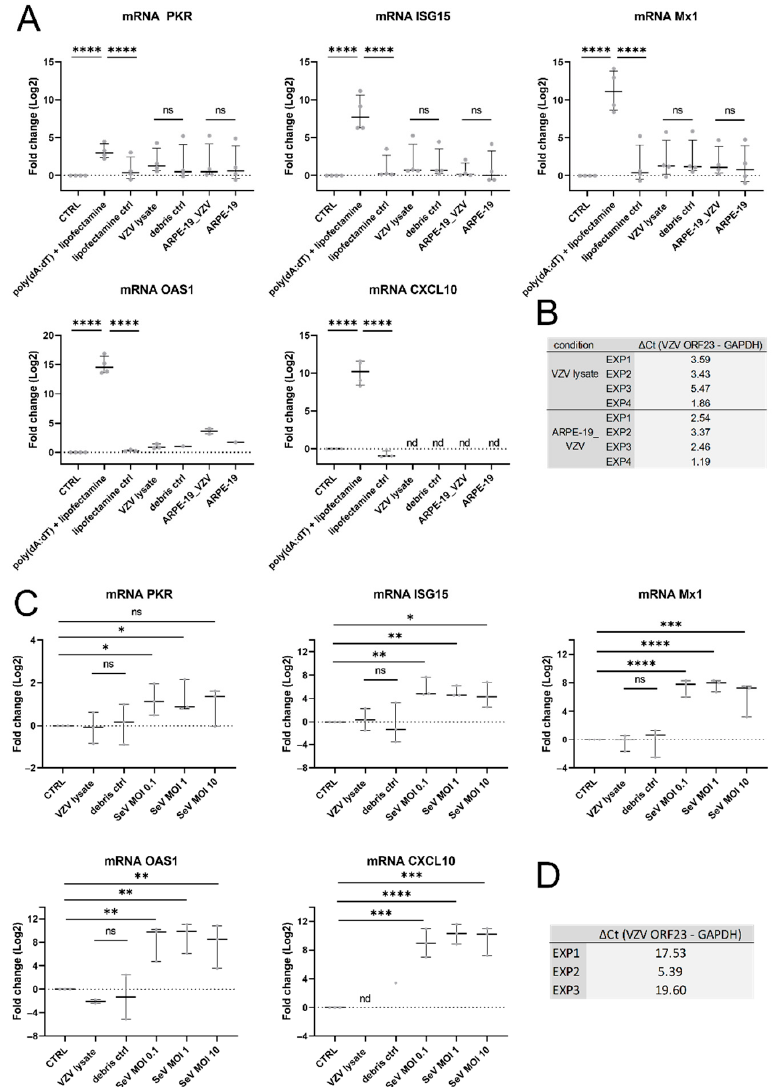
Figure 5. VZV infection does not result in ISG-upregulation in hiPSC neurons. ( A , B ) hiPSC neurons were inoculated with ARPE-19-associated eGFP-ORF23 VZV (ARPE-19_VZV) at a 1:5 ratio or with 1.5 × 10 2 PFU eGFP-ORF23 VZV lysate or their respective control for 72 h. Poly(dA:dT) stimulation for 24 h served as a positive control for the induction of ISGs. Cell lysates were analyzed by RTqPCR. ( A ) Transcript expression (log2) was set out relative to the mean of the untreated non-infected control group (CTRL), i.e., fold change. Each dot represents the log2 fold change of a single culture originating from one of four independent biological repeats. Lines with whiskers indicate the median with interquartile range. The p values reported were obtained from a Linear Mixed Model that was adjusted for multiple testing using Dunnett’s comparisons with control test. ( B ) ∆ Ct values for VZV ORF23 mRNA (Ct VZV ORF23-Ct hGAPDH) are shown. ( C , D ) hiPSC neurons were (i) inoculated with 1.5 × 10 2 PFU eGFP-ORF23 VZV lysate or with the debris control for 24 h, or (ii) inoculated with SeV-GFP4 (SeV) for 24h at different MOIs. Cell lysates were analyzed by RTqPCR. ( C ) Transcript expression (log2) was set out relative to the mean of the untreated non-infected control group (CTRL), i.e., fold change. Each dot represents the log2 fold change of a single culture originating from one of three independent biological repeats. Lines with whiskers indicate the median with interquartile range. The p values reported were obtained from a Linear Mixed Model that was adjusted for multiple testing using Tukey HSD all-pairwise comparison test. ( D ) ∆ Ct values for VZV ORF23 mRNA (Ct VZV ORF23-Ct hGAPDH) are shown. * p < 0.05, ** p < 0.01, *** p < 0.001, **** p < 0.0001, ns: not significant, nd: not detected (originating from Ct > 40 for the